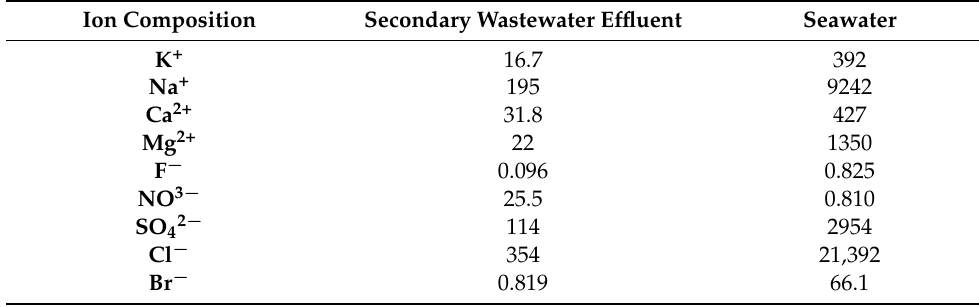
Table 2. Major constituent ions of seawater and secondary wastewater effluent